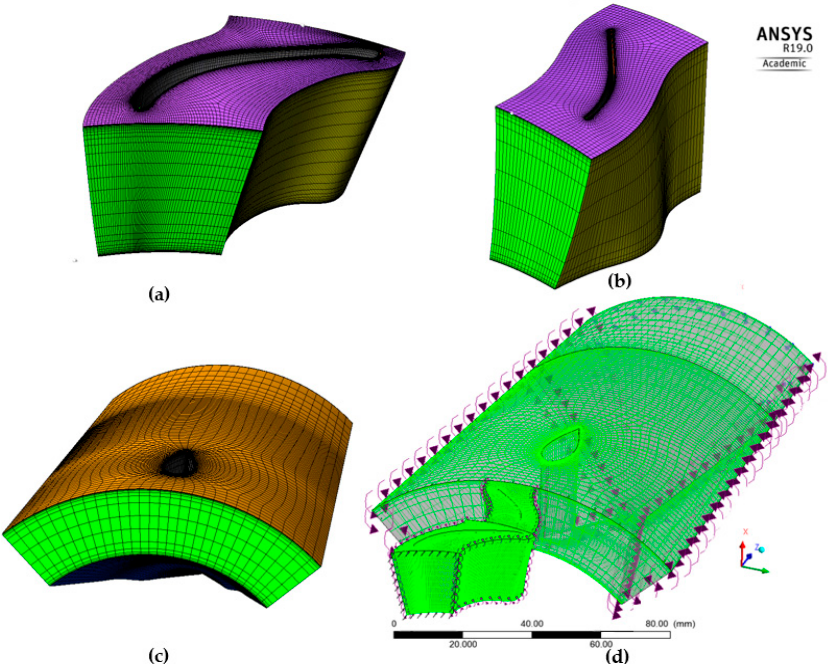
Figure 3. ( a ) Meshed stator blade of the iSTC-21v jet engine; ( b ) meshed turbine blade of the iSTC-21v jet engine; ( c ) meshed nozzle of the iSTC-21v jet engine; ( d ) computational CFD domain of the turbine section and nozzle.